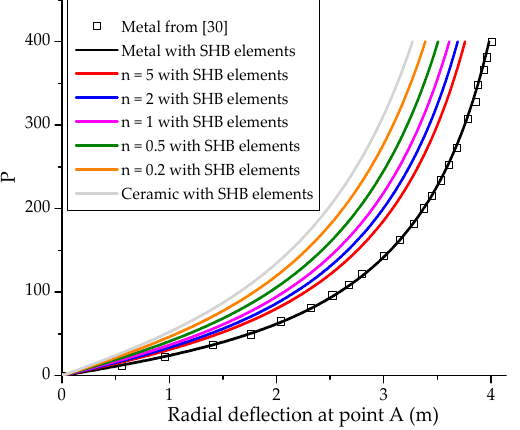
Figure 19. Load–displacement curves at point A for the pinched hemispherical shell, obtained with a mixture of prismatic SHB15 and hexahedral SHB20 elements.